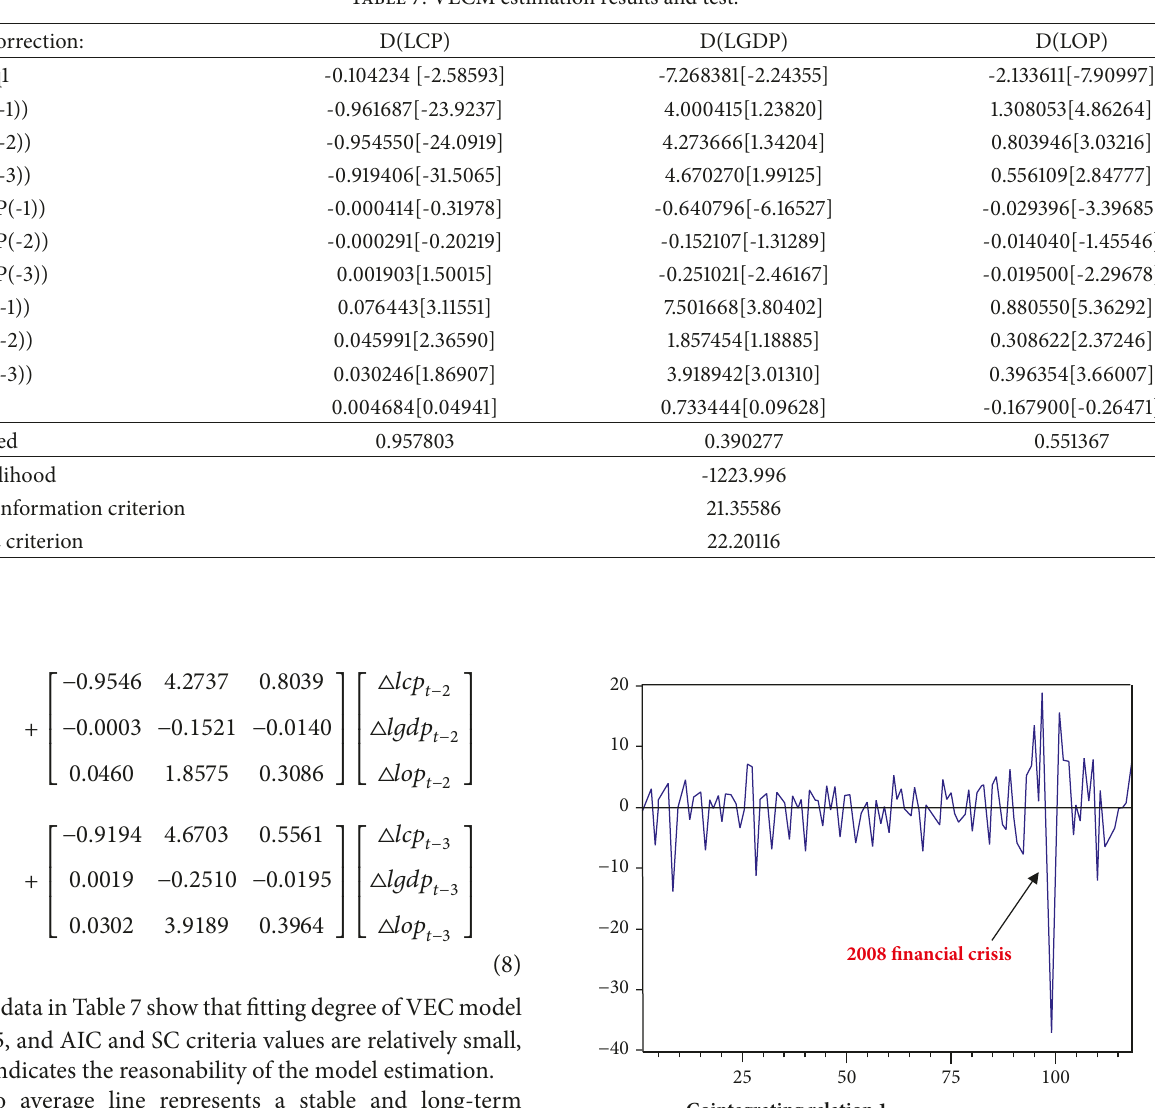
Table 7: VECM estimation results and test.